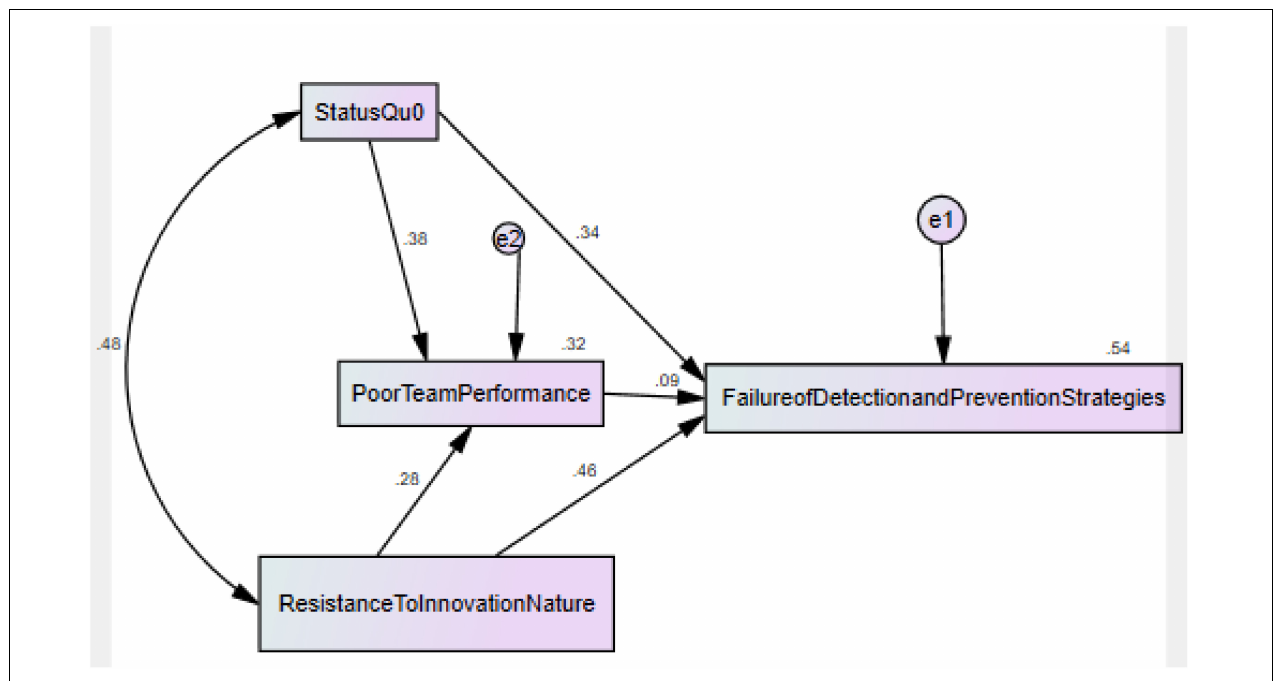
FIGURE 4 | Structural model